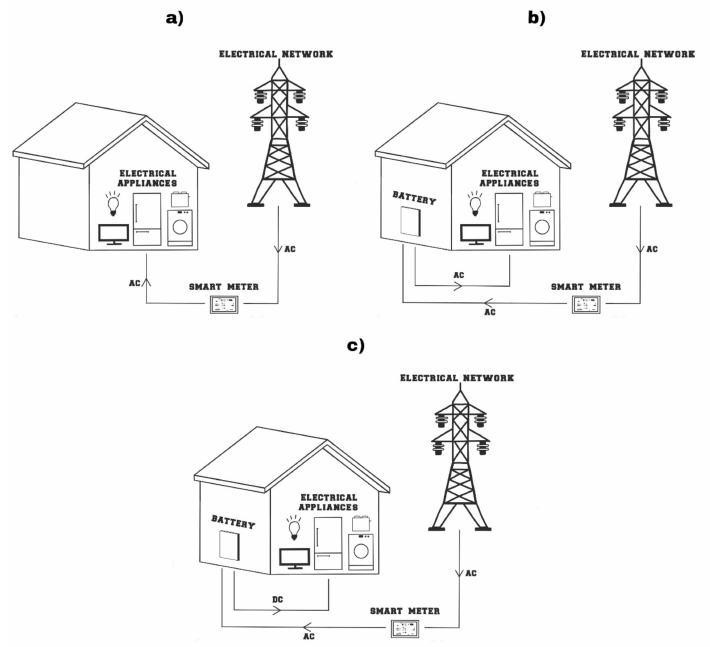
Figure 1. Simplified architecture of the proposed models: ( a ) Current AC system. ( b ) AC system with battery. ( c ) Combined AC / DC system with